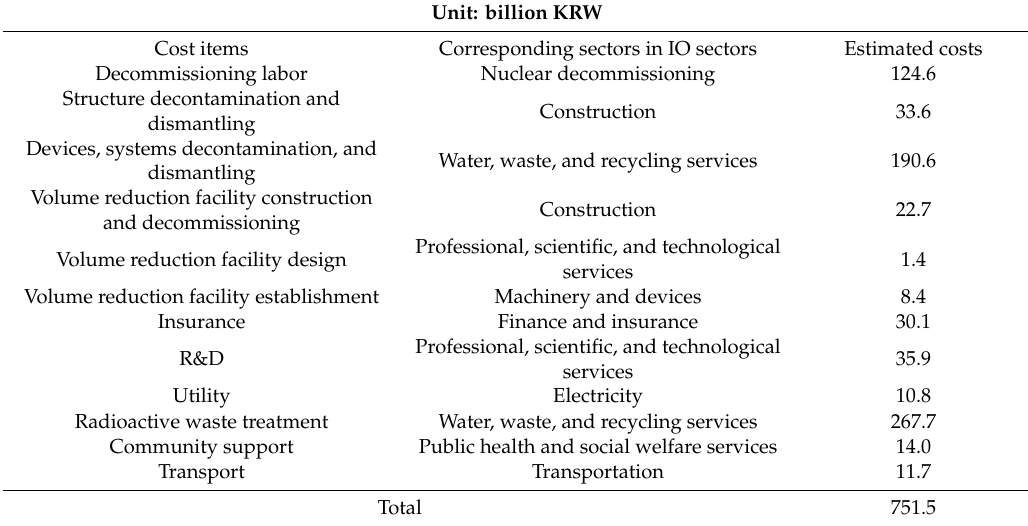
Table A2. Allocation of the decommissioning cost items to corresponding IO sectors and estimated